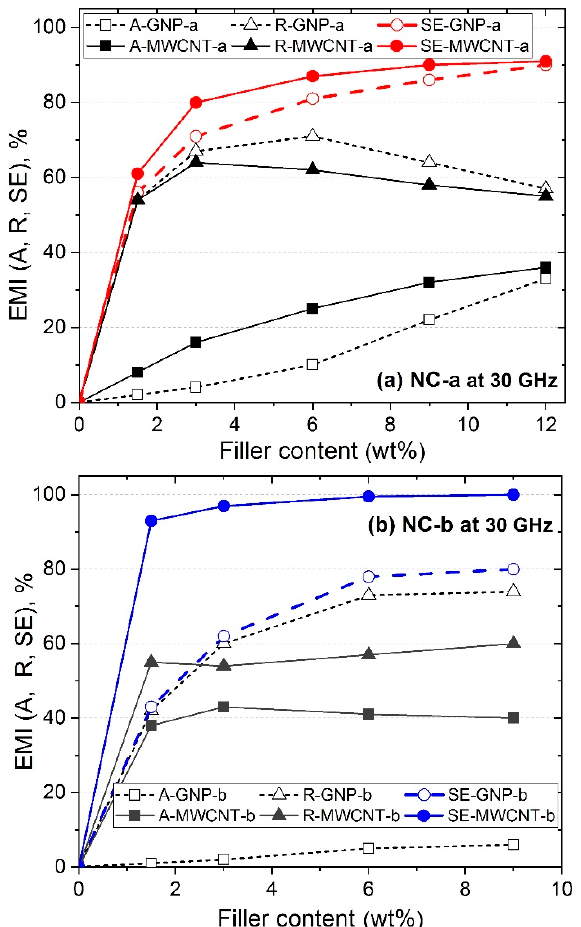
Figure 9. Reflection (R), absorption (A) and electromagnetic shielding efficiency (SE) of nanocomposites, with GNPs and MWCNTs, as varying the filler contents, for the PLA-based nanocomposite series: ( a ) NC-a and ( b ) NC-b.